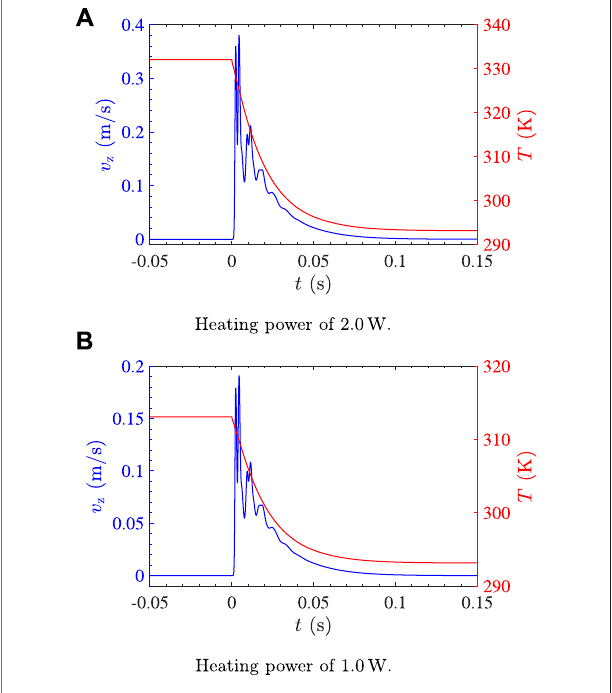
FIGURE5 | Simulated fl owvelocity inthe center ofthe tube at theheight of the electrodes on the left axis and maximum temperature of the plasma volume on the right axis. The heating power is (A) 2.0 W and (B) 1.0